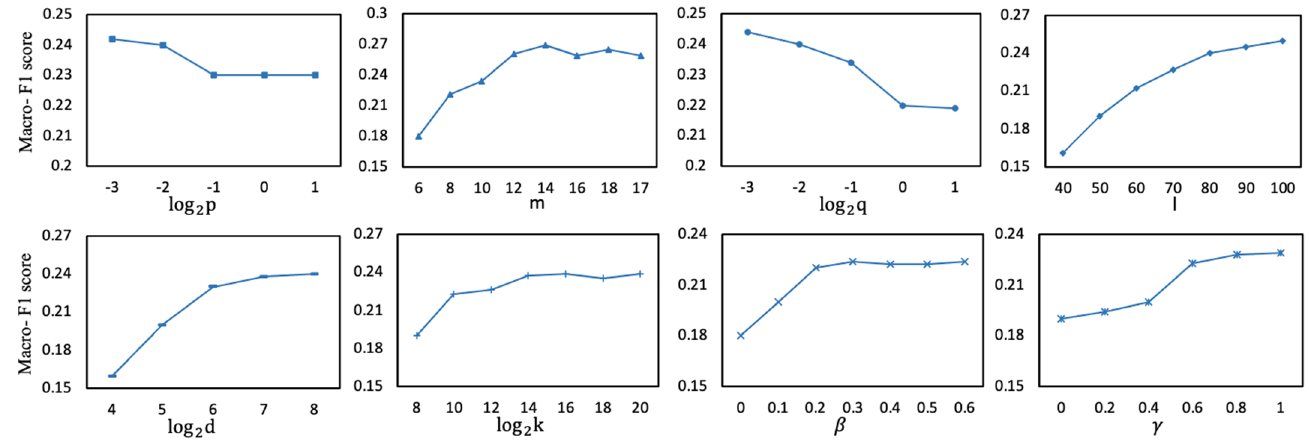
Figure 6. Parameter influence analysis.